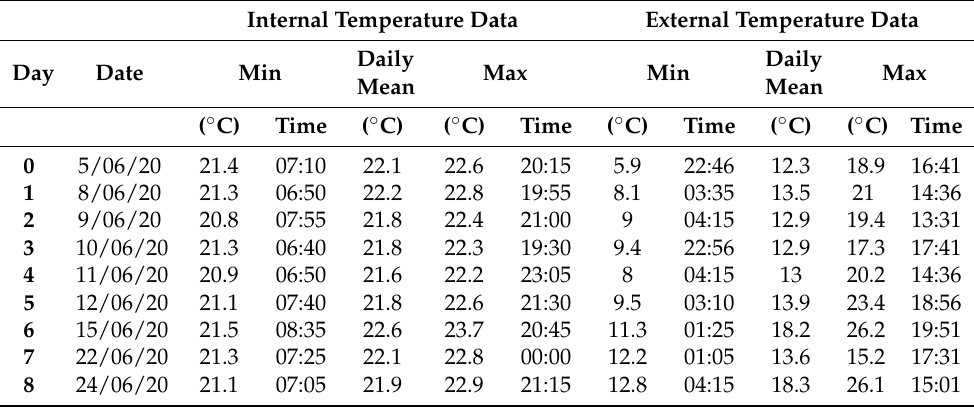
Table 3. Field measurements and external temperature data collected from the case study